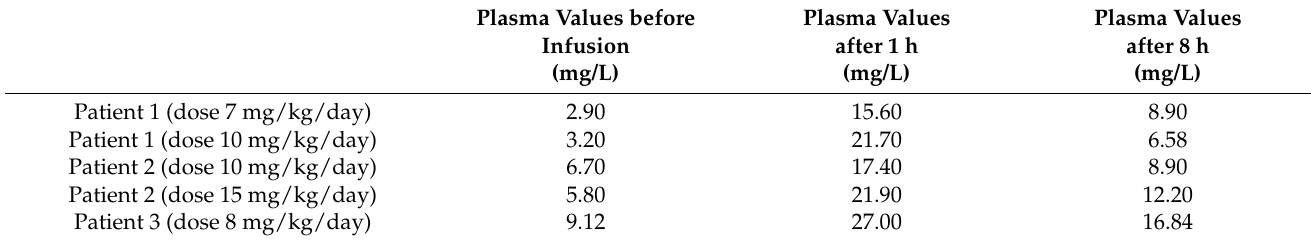
Table 4. Plasma micafungin concentrations in three patients before and after different dose infusions.